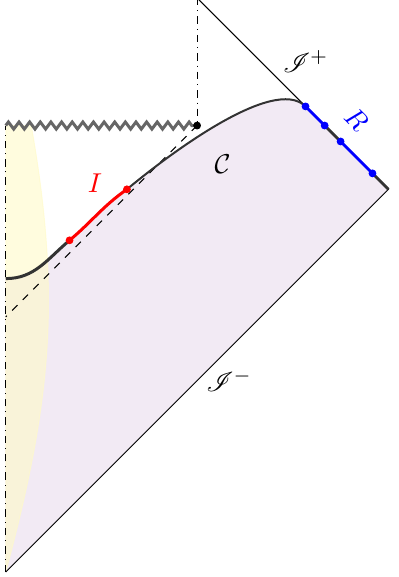
Figure 1 . The Penrose diagram for the evaporating black hole formed from collapse in an asymptotically flat spacetime. The Hawking radiation is collected in a subset R ⊂ I + which lies in a Cauchy surface C that avoids the high curvature region near the singularity and the end-point of evaporation but includes any QES that can contribute. The functional integral is defined on the pink region from I − up to the Cauchy surface where boundary conditions in the form of gluing conditions between copies of the spacetime are imposed in order to compute the (Rényi) entropies of the state on R